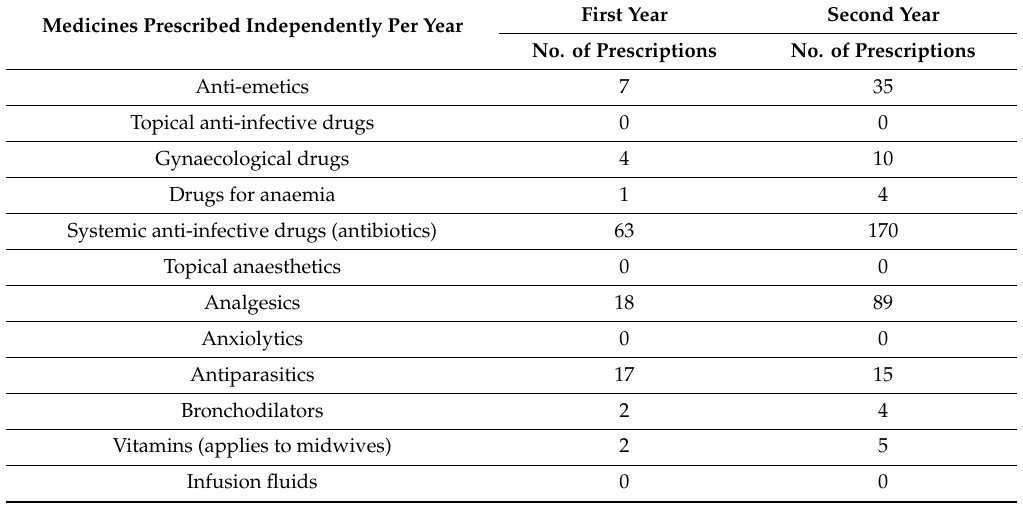
Table 5. Groups of medicines prescribed by nurse independent prescribers during the implementation period. Medicines Prescribed Independently Per Year